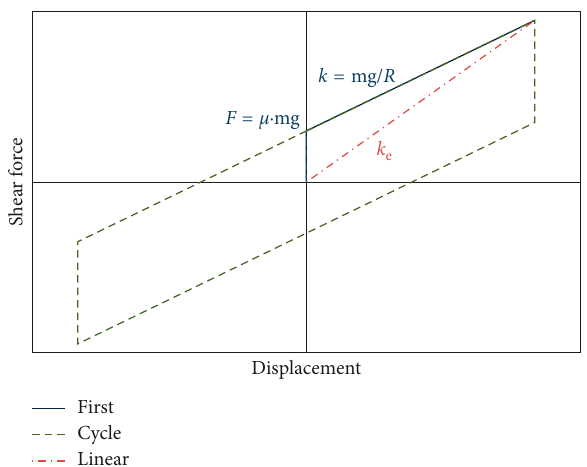
Figure 6: Typical diagram of the dynamic friction coefficient versus velocity and pressure.